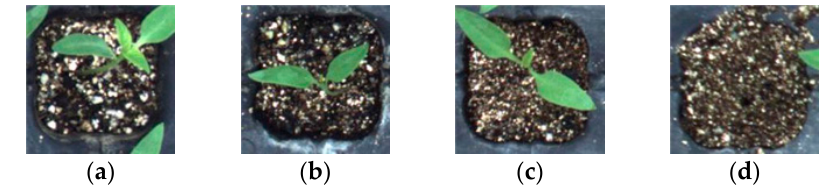
Figure 3. Different classes of plug seedlings. ( a ) Example of seedlings with two true leaves. ( b ) Examples of seedlings with no true leaf. ( c ) Example of seedling with one true leaf. ( d ) Example of lack of seedlings.